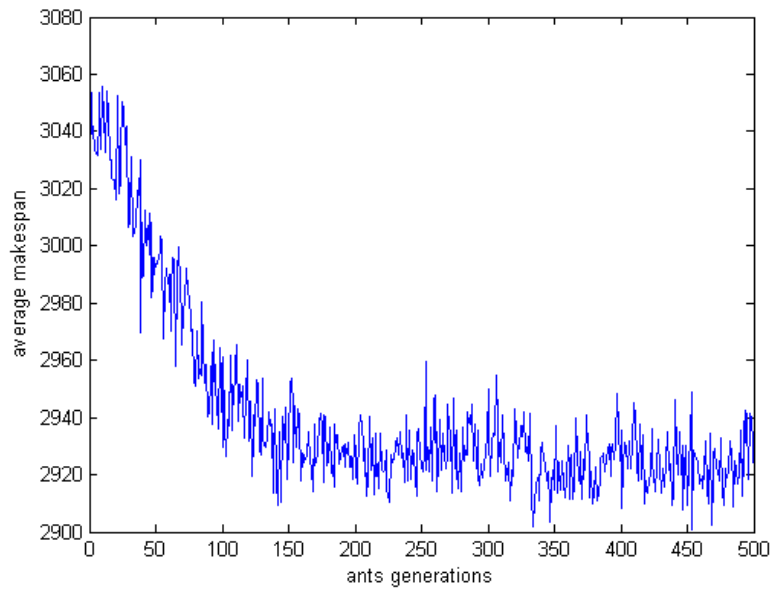
Figure 5. Relationship between ants generations and the average makespan in each generation (total computation time of 20